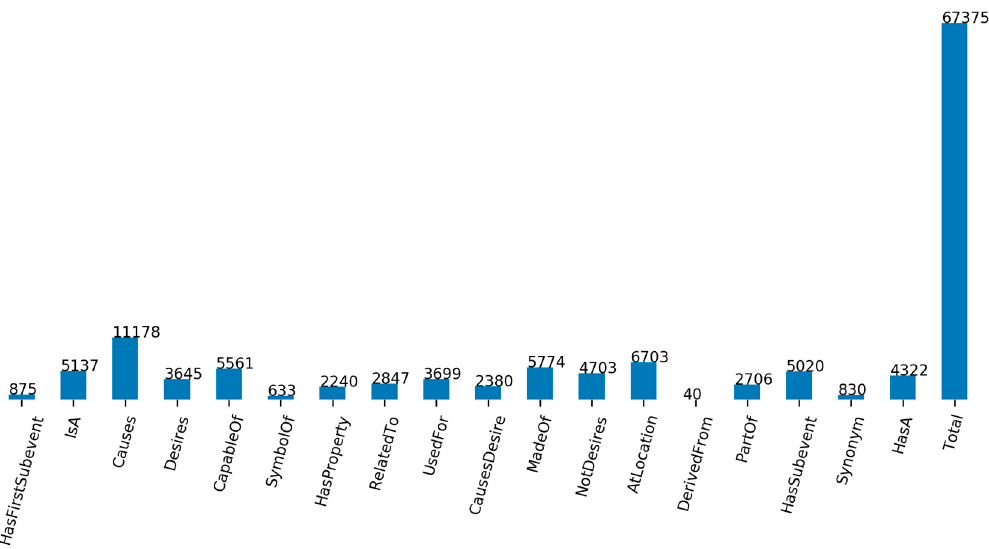
Figure 4. Results of filtered Uyghur facts for each relationship type.